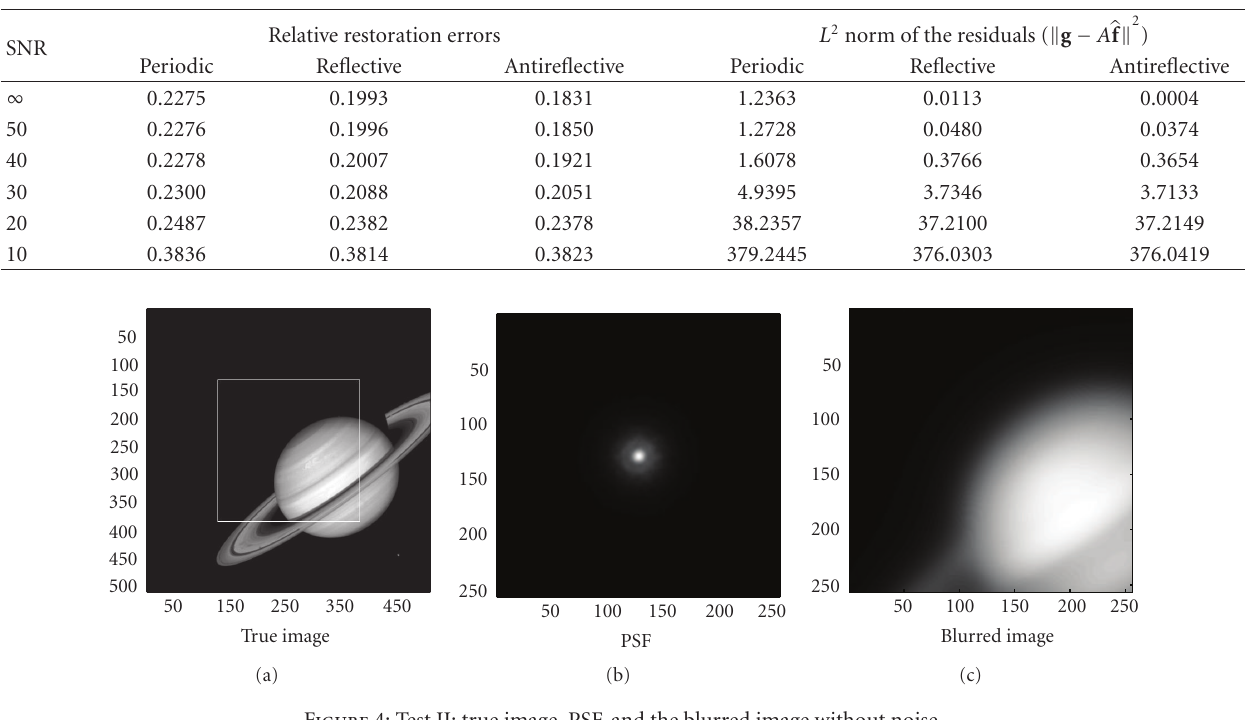
Table 2: Test I: best RREs and L 2 norm of the residuals for CG with reblurring varying the SNR (SNR = ∞ means 0% of noise).